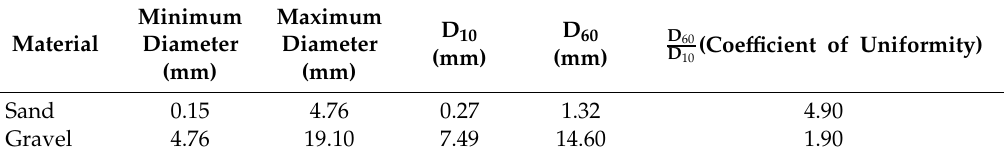
Table 3. Granulometric data for sand and gravel.